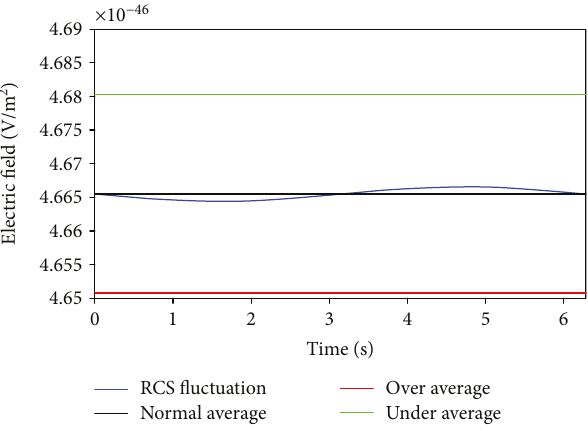
Figure 3: Simulation results of echo fl uctuation under three average